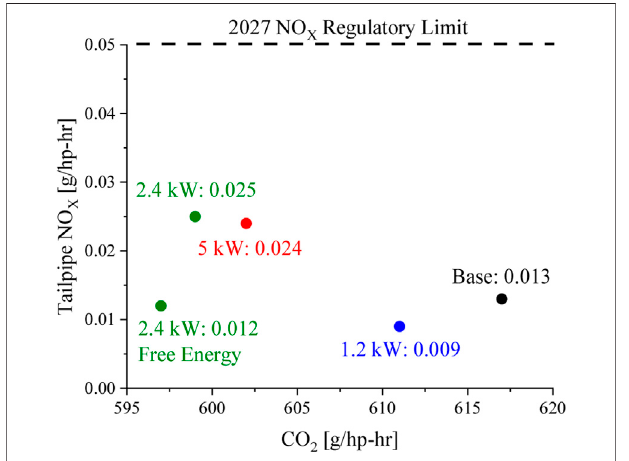
FIGURE 9 | LLC results.